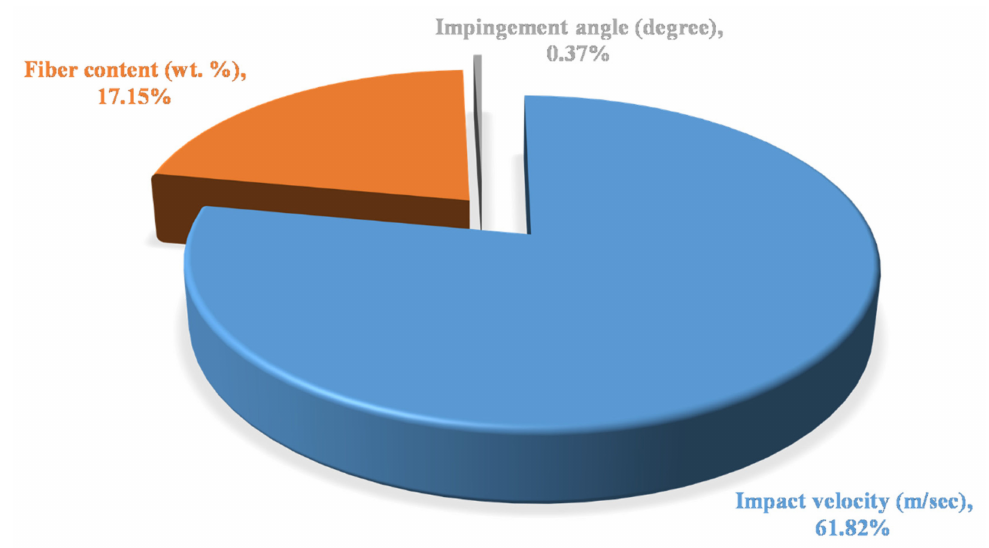
Figure 8. Contribution chart of factors for vinyl ester-based composites.